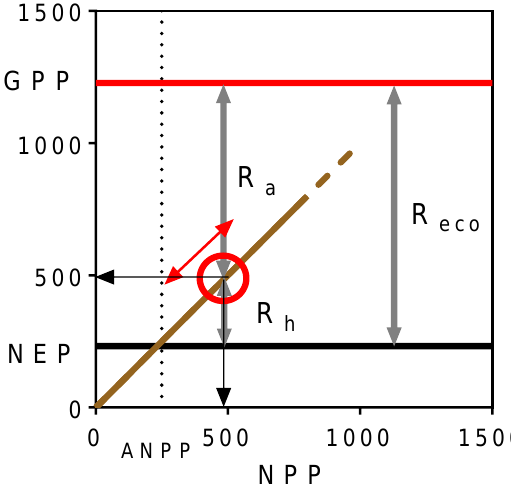
Figure 2. Scheme showing how the biometric estimate of NPP de- termines the partition of R eco in its components R a and R h . In this figure, we plot GPP, NEP and NPP at their average values. The red arrow shows how errors in estimating NPP propagate in R a and R h . All variables are expressed in gCm − 2 yr − 1